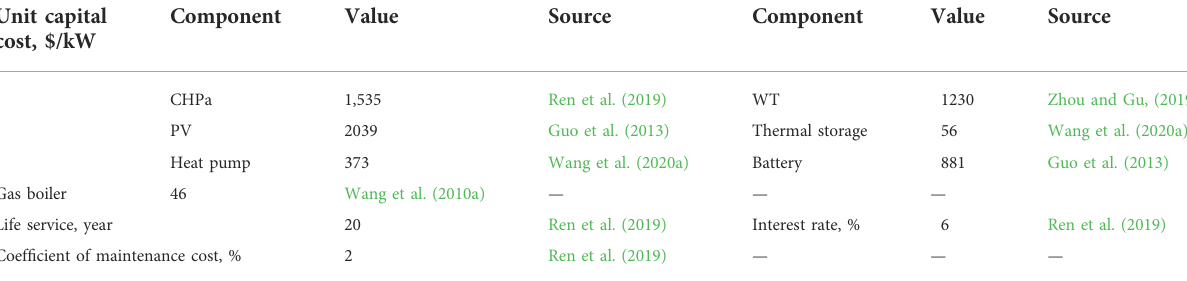
TABLE 2 Economic parameters.